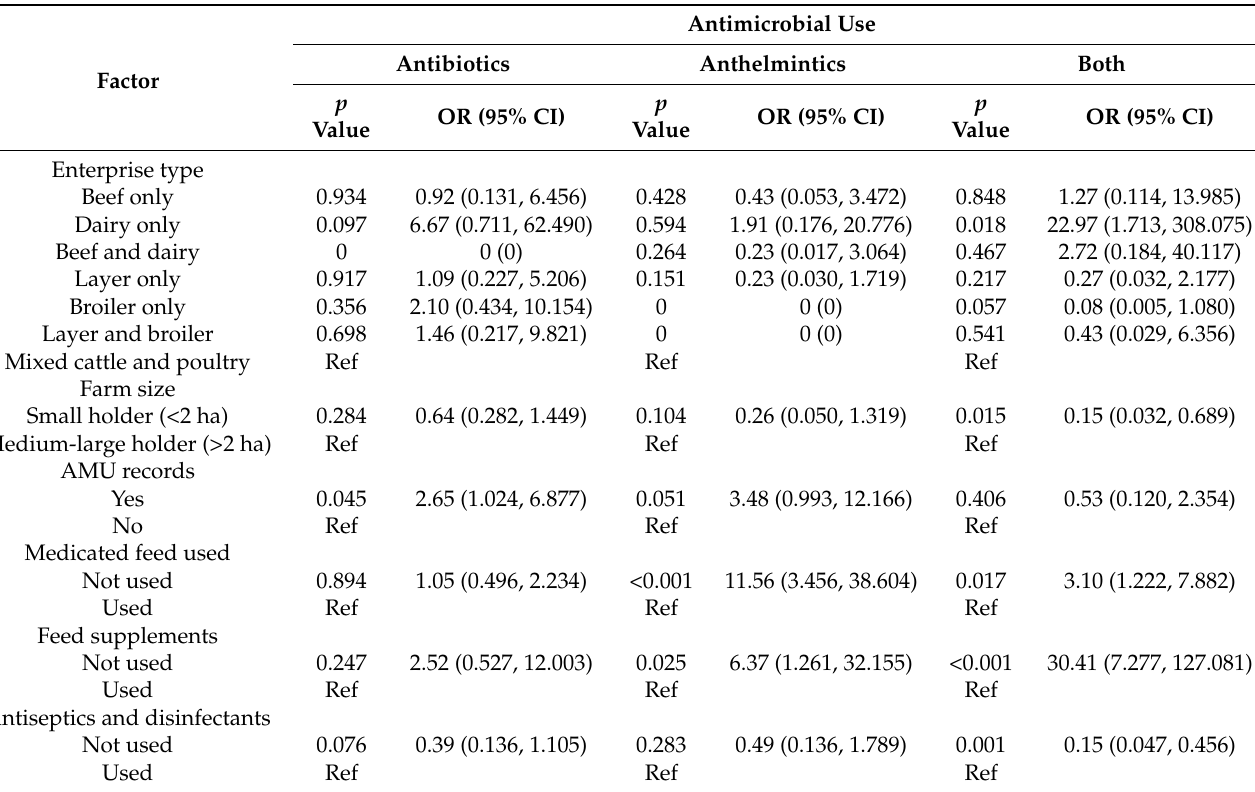
Table 2. Multinomial logistic modelling analysis of factors (farmer, livestock production and management) with antimicrobial use on 236 livestock farms located in Central and Western divisions of Viti Levu,